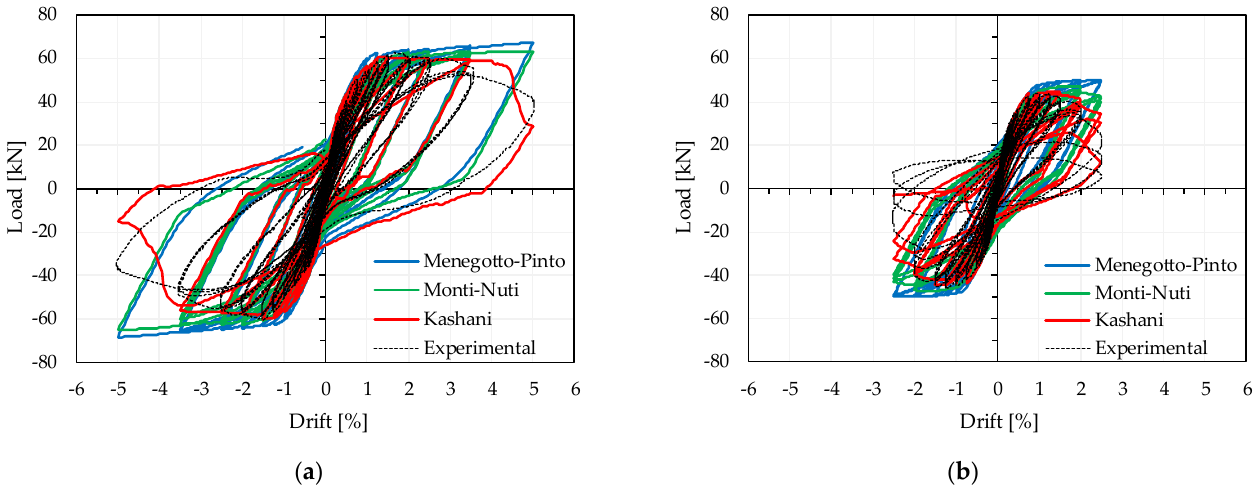
Figure 5. Comparison between the experimental and numerical responses in terms of load-drift curve: ( a ) un-corroded column, ( b ) corroded column.